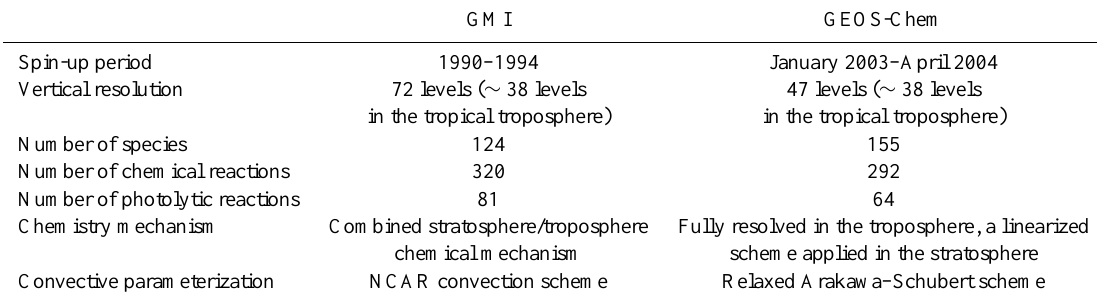
Table 1. Differences between GMI model and GEOS-Chem model run.